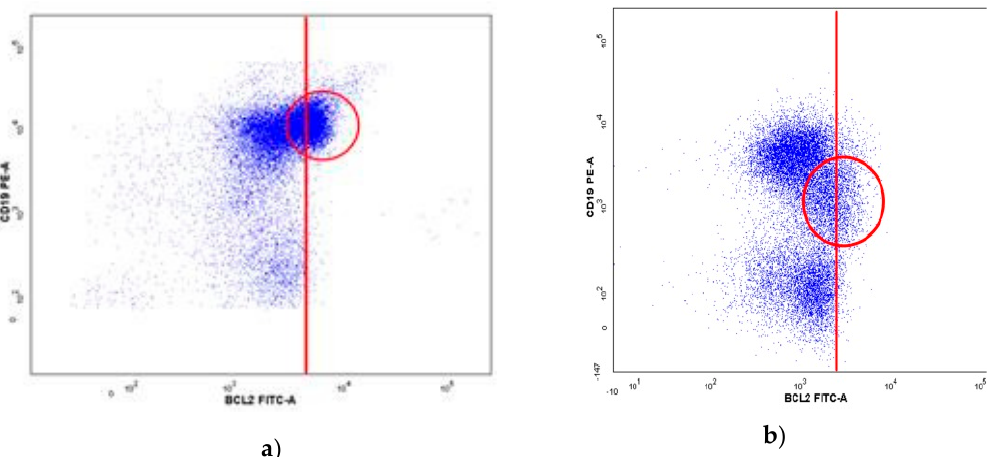
Figure 3. Positive qualitative Bcl-2 test in two samples with negative quantitative Bcl-2 test. Results of Bcl-2 measurement in B-cell and in T-cells, where we observe two populations of B-cells with different expression of Bcl-2 and a population of T-cells. ( a ) a small B-cell population with Bcl-2 overexpression which was not detected by the quantitative test. ( b ) Positive qualitative Bcl-2 test with few T-cells which resulted into false negative quantitative Bcl-2 test. Red circles show B-cells with Bcl-2 overexpression. Sensitivity, specificity, PPV and NPV for each type of Bcl-2 test as well as for the combination of both types are shown in Table 1. Table 1. Sensitivity, specificity, PPV and NPV of the qualitative and quantitative Bcl-2 test for differentiation between RLP and BCL.